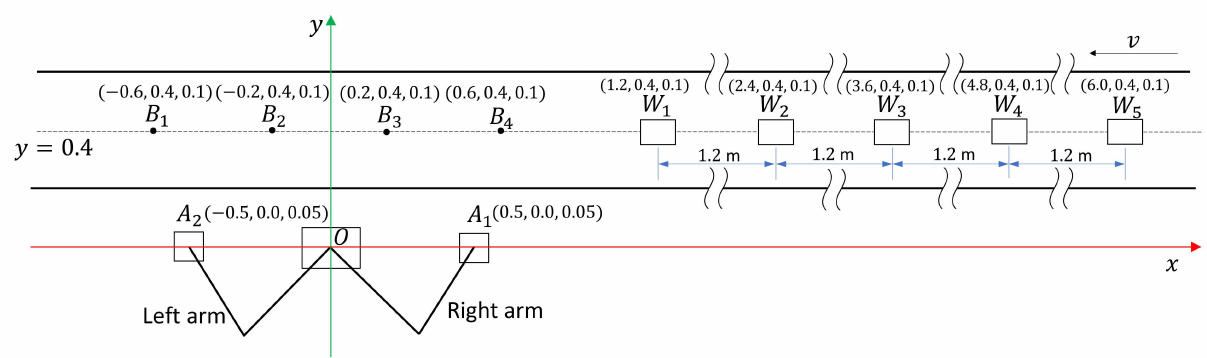
Figure 1. Workpiece transport model using a dual-arm